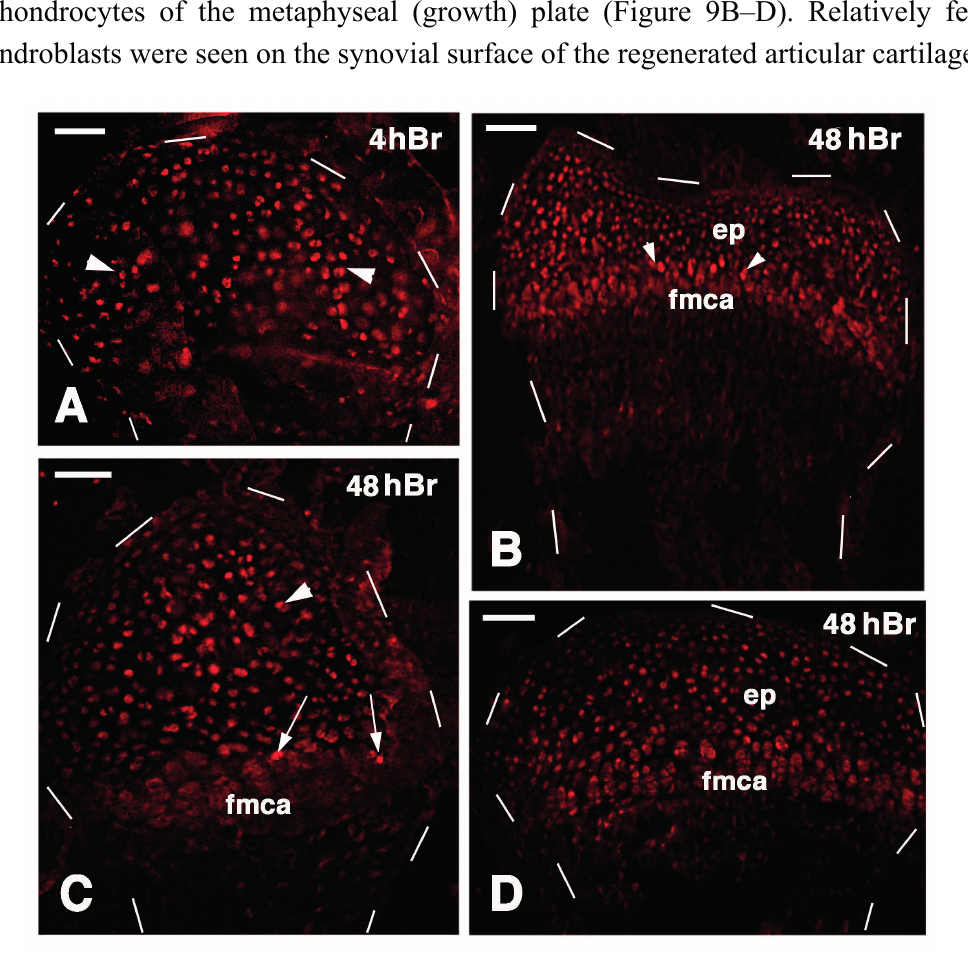
Figure 9. Immunolocalization of labeled cells in 21 lesioned knee epiphyses 4 h post-injection of 5Brdu ( A ) and 48 h post-injection ( B – D ). Dashes outline the perimetry of the articular cartilage down to the diaphysis. ( A ) Tibia epiphyses formed by numerous labeled inner chondrocytes (arrowheads). Bar, 50 µm; ( B ) Sparse labeled cells in the femur epiphysis (ep) where the forming metaphyseal plate (fmca) also contains few clearly labeled cells (arrowheads). Bar, 50 µm; ( C ) Distributed labeled cells in a cartilaginous epiphyses (arrowhead) and in the forming metaphyseal plate (fmca, arrows) of a fibula. Bar, 50 µm; ( D ) Distributed labeled cells in the epiphysis (ep) and sparse labeled cells in the serial cartilage of the forming metaphyseal cartilage (fmca) of a tibia. 50